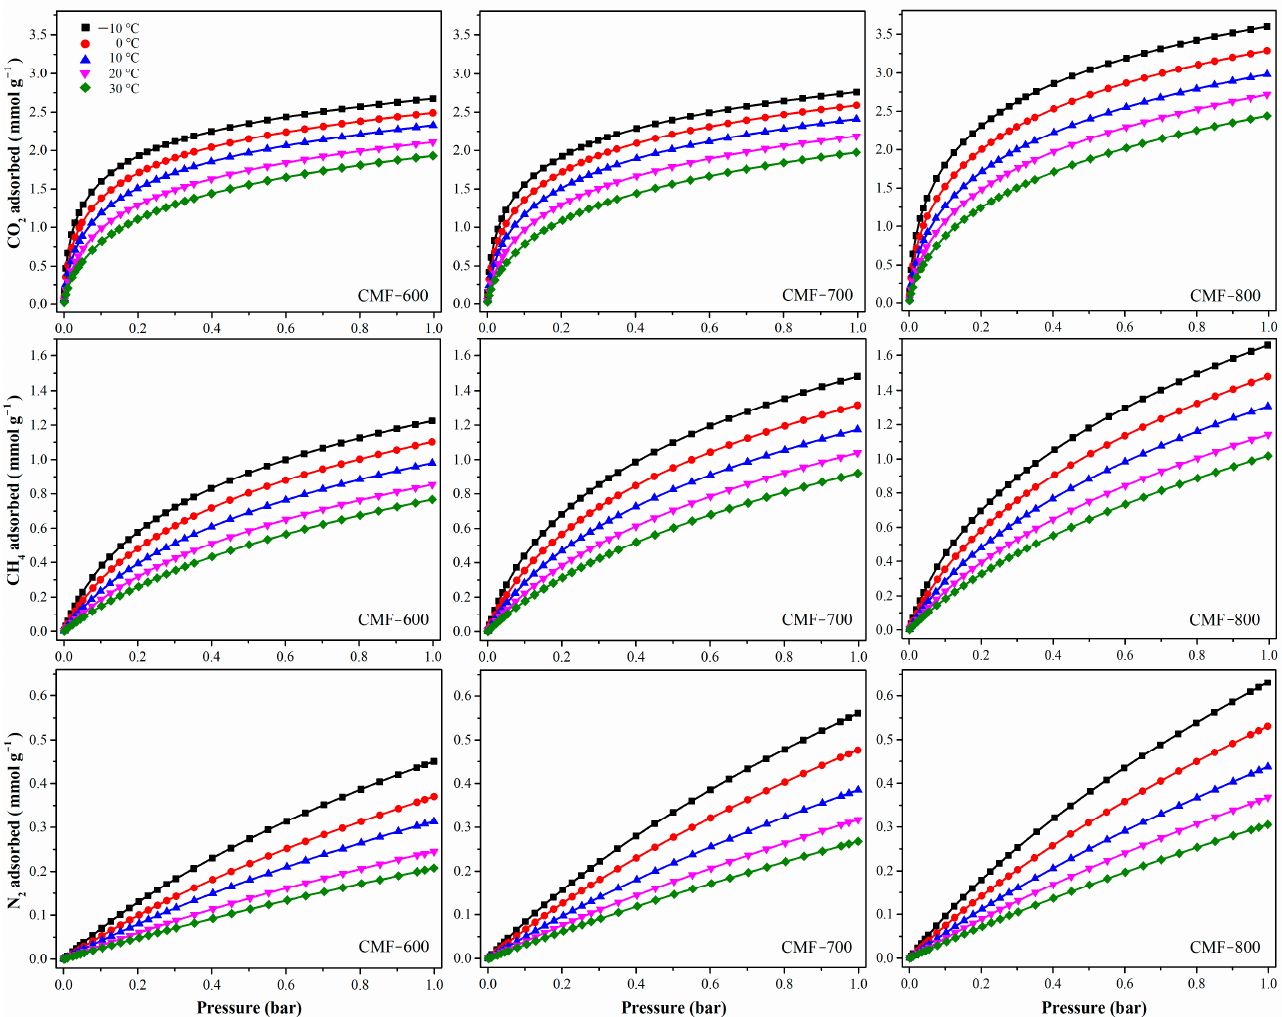
Figure 9. CO 2 , CH 4 , and N 2 isotherms of CMFs at − 10 °C, 0 °C, 10 °C, 20 °C, and 30 °C. The isosteric enthalpy of CO 2 adsorption at low surface coverage was around − 33.8, − 32.3, and − 31.4 kJmol − 1 for materials CMF-600, CMF-700, and CMF-800, respectively. These values decrease with an increment in surface coverage, which can be associated with the energy heterogeneity of the carbon microfibers surface adsorption sites. The isosteric enthalpy of adsorption of these materials followed the order: CMF-600 > CMF- 700 > CMF-800, so the interaction of CO 2 with CMF-600 was stronger than with CMF-800, because it released a greater amount of energy. The behavior is similar in the isosteric